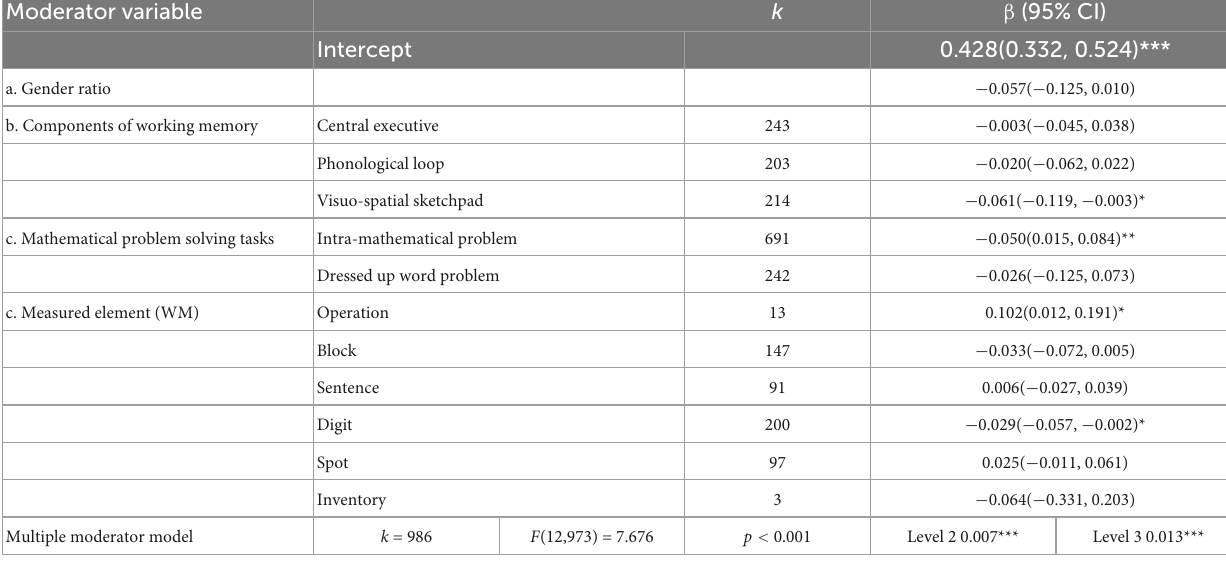
TABLE 3 Multiple moderator model on the relation between working memory (WM) and mathematical problem solving